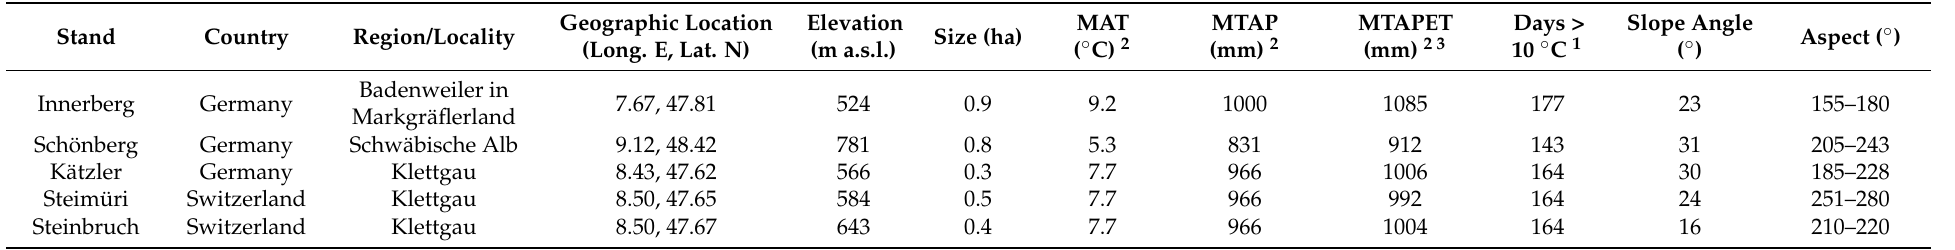
Table 1. Topographic and climatic characteristics of five oak–beech forests on Jurassic limestone (rendzina soil) from three locations in southern Germany and northern Switzerland.